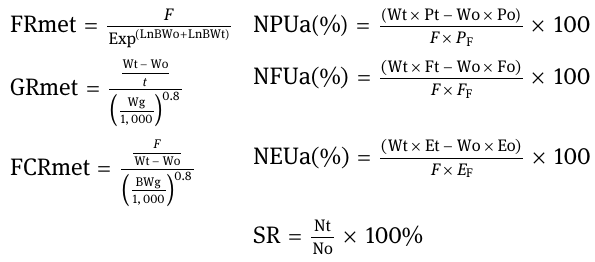
Table 1: Metabolic feed ration of Nile tilapia cultured in RAS and BFSs calculated on days 7, 14, 28, and 42 Day